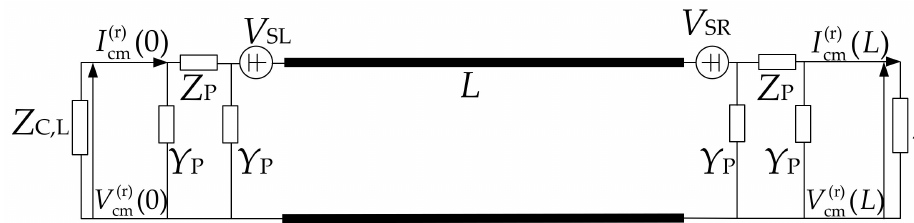
Figure 3. CM circuit in radiation